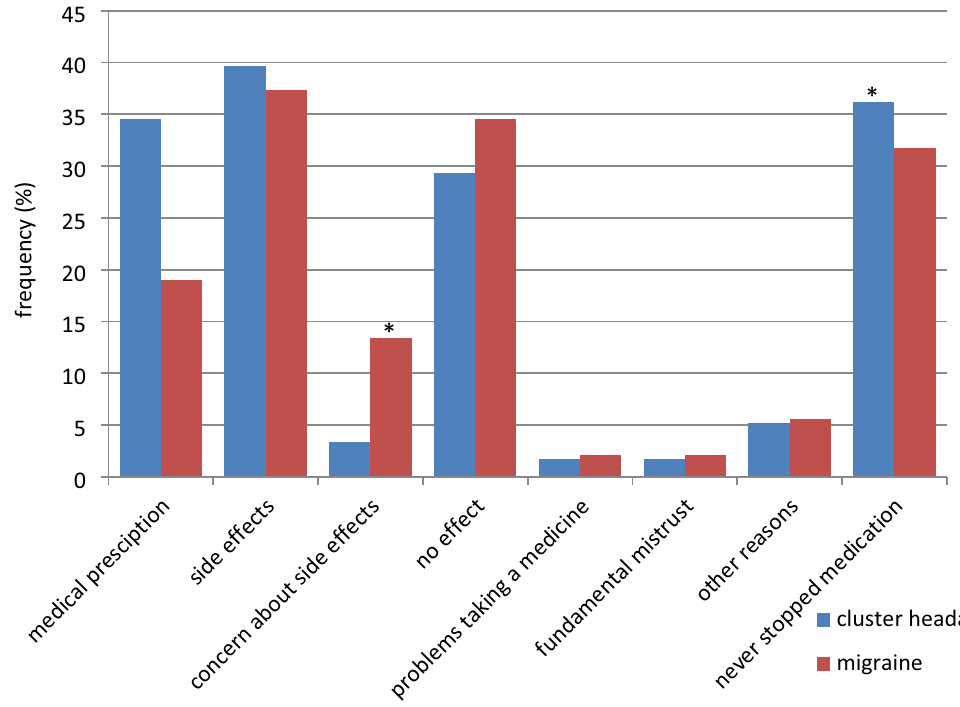
Figure 2. Reasons for stopping the medication in percent; * p ≤